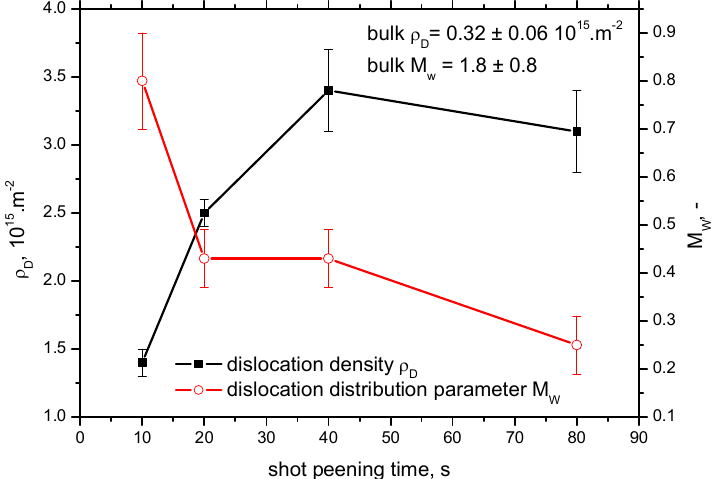
Figure 12. Dislocations density and their distribution versus shot peening time.